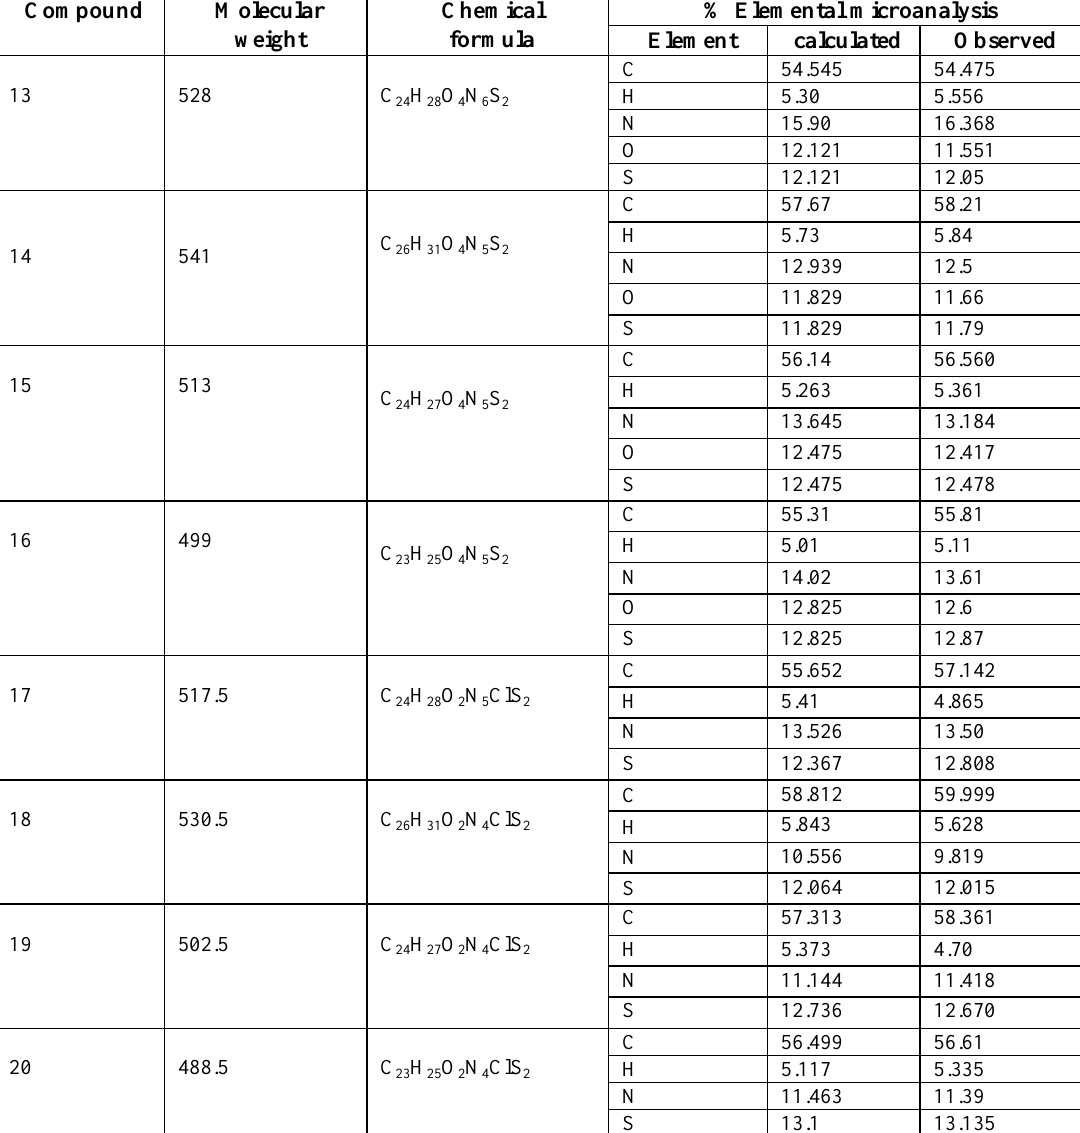
Table (3): Elemental microanalysis of the final compounds (13-20)